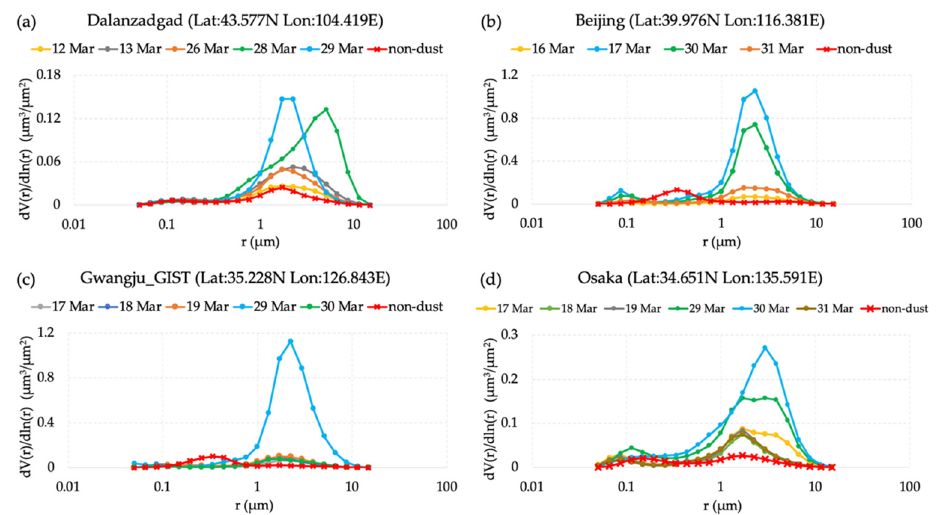
Figure 3. Aerosol volume size distribution at four AERONET sites: ( a ) Dalanzadgad site; ( b ) Beijing site; ( c ) Gwangju site; and ( d ) Osaka site during the two dust events. Lines with a solid circle are dust days, and red lines with an “×” label are non-dust days.